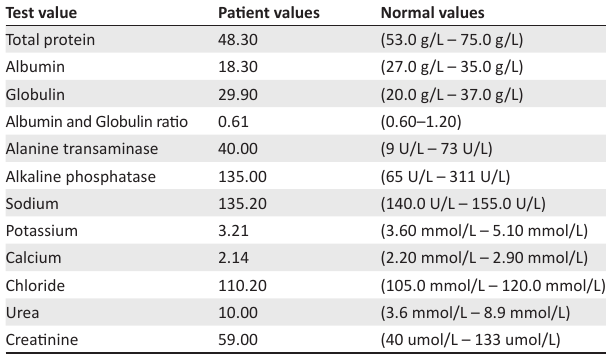
TABLE 3: Biochemistry